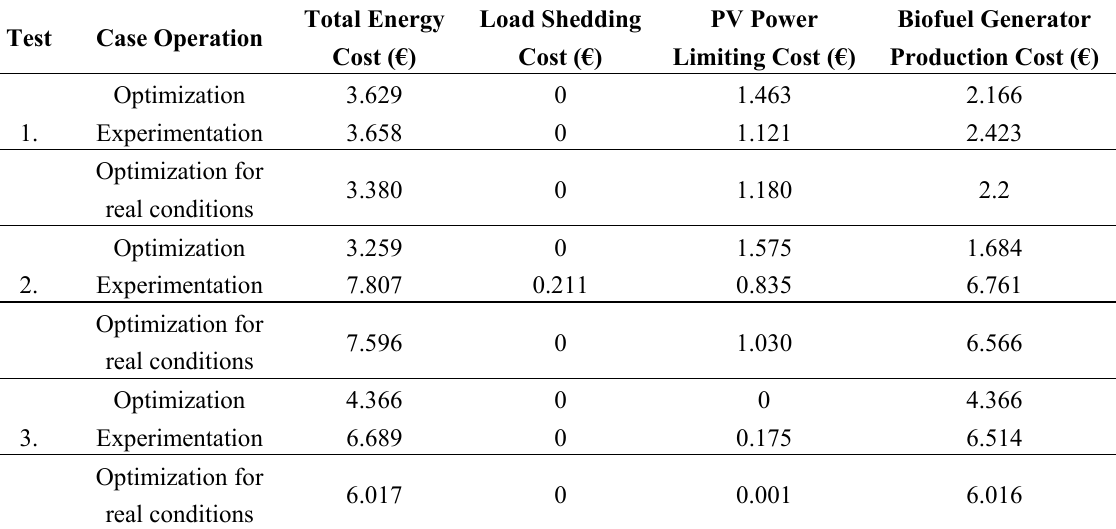
Table 5. Energy cost comparison between the operated three